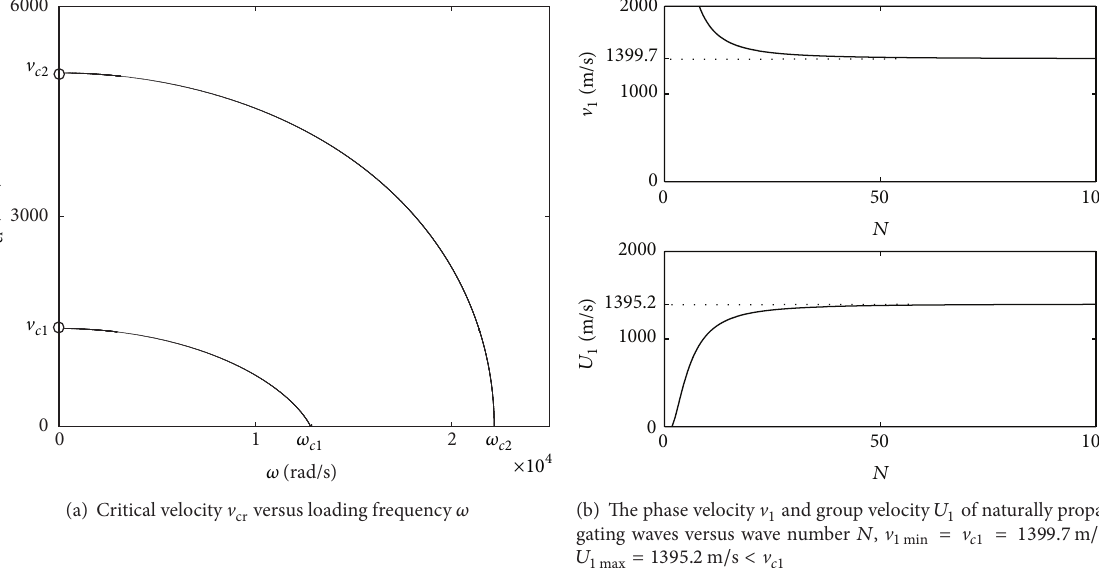
(a) Critical velocity V cr versus loading frequency 𝜔 (b) The phase velocity V 1 and group velocity 𝑈 1 of naturally propa- gating waves versus wave number 𝑁 , V 1 min = V 𝑐1 = 1399.7 m / s, 𝑈 1 max = 1395.2 m / s < V 𝑐1 Figure 6: Critical velocity V varies with loading frequency 𝜔 for 𝑘 = 1 × 10 10 N/m 2 cr